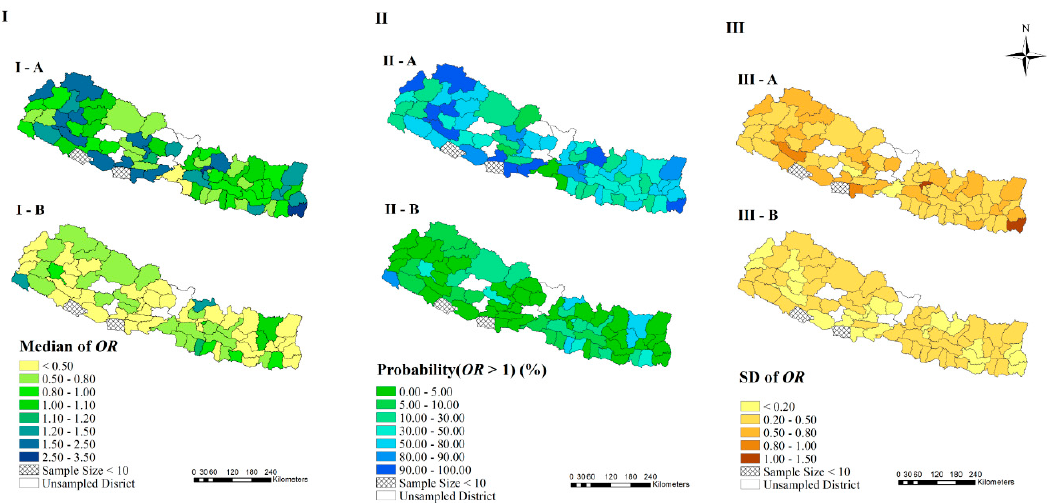
Figure 4. The temporal changes of risk across survey years. (I-A) and (I-B) present the median of posterior distribution of OR during the years 2011 – 2006 and 2016 – 2011, respectively. (II-A) and (II- B) present the probability of OR larger than one for 2011 – 2006 and 2016 – 2011, respectively. (III-A) and (III-B) present the SD of posterior distribution of OR for 2011 – 2006 and 2016 – 2011,